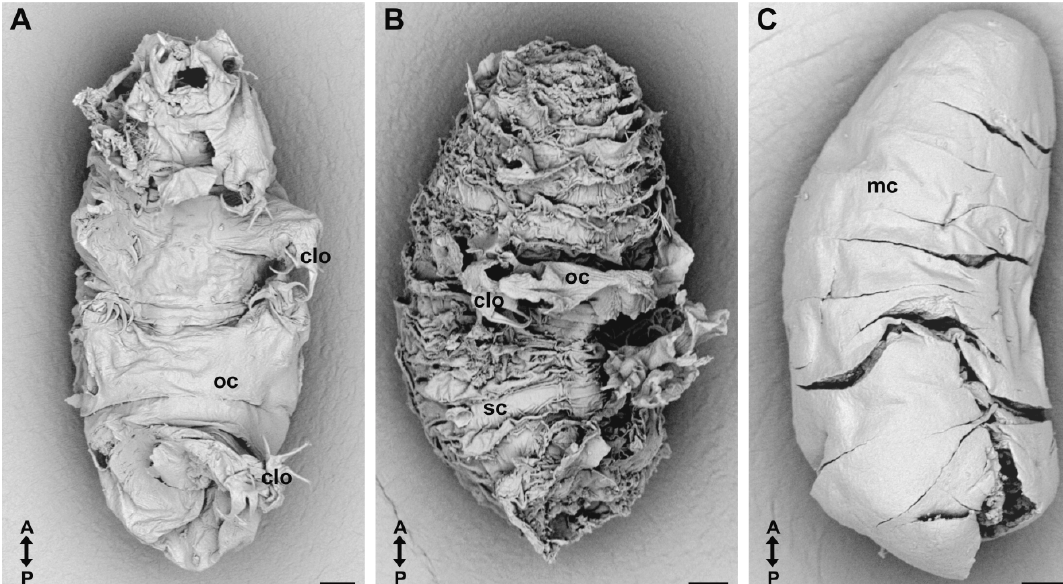
Figure 3. Cuticles of the cuticular capsule, SEM. ( A ) Old cuticle (external cuticle), ventral view; ( B ) sarcophagus cuticle (middle cuticle) with the remains of the old cuticle with claws, ventro-lateral view; ( C ) mummy cuticle (inner cuticle). Scale bars 10 μ m. Old cuticle (oc); claws of the old cuticle (clo); mummy cuticle (mc); sarcophagus cuticle (sc). Note that A–P indicates anterior to posterior direction.